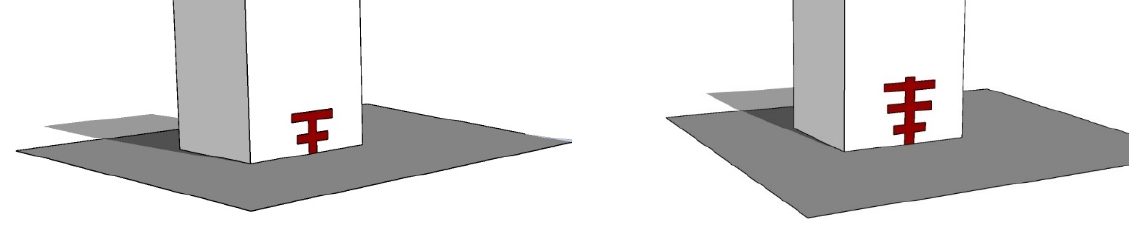
Figure 3. Evolution of the RDRA wideband antenna (3-D View) ( a ) Antenna-A, RDRA with the T- shape feed; ( b ) antenna-2, RDRA with a novel flat surface metal strip (Yagi-Uda); ( c ) desired wideband RDRA with the parasitic patch.